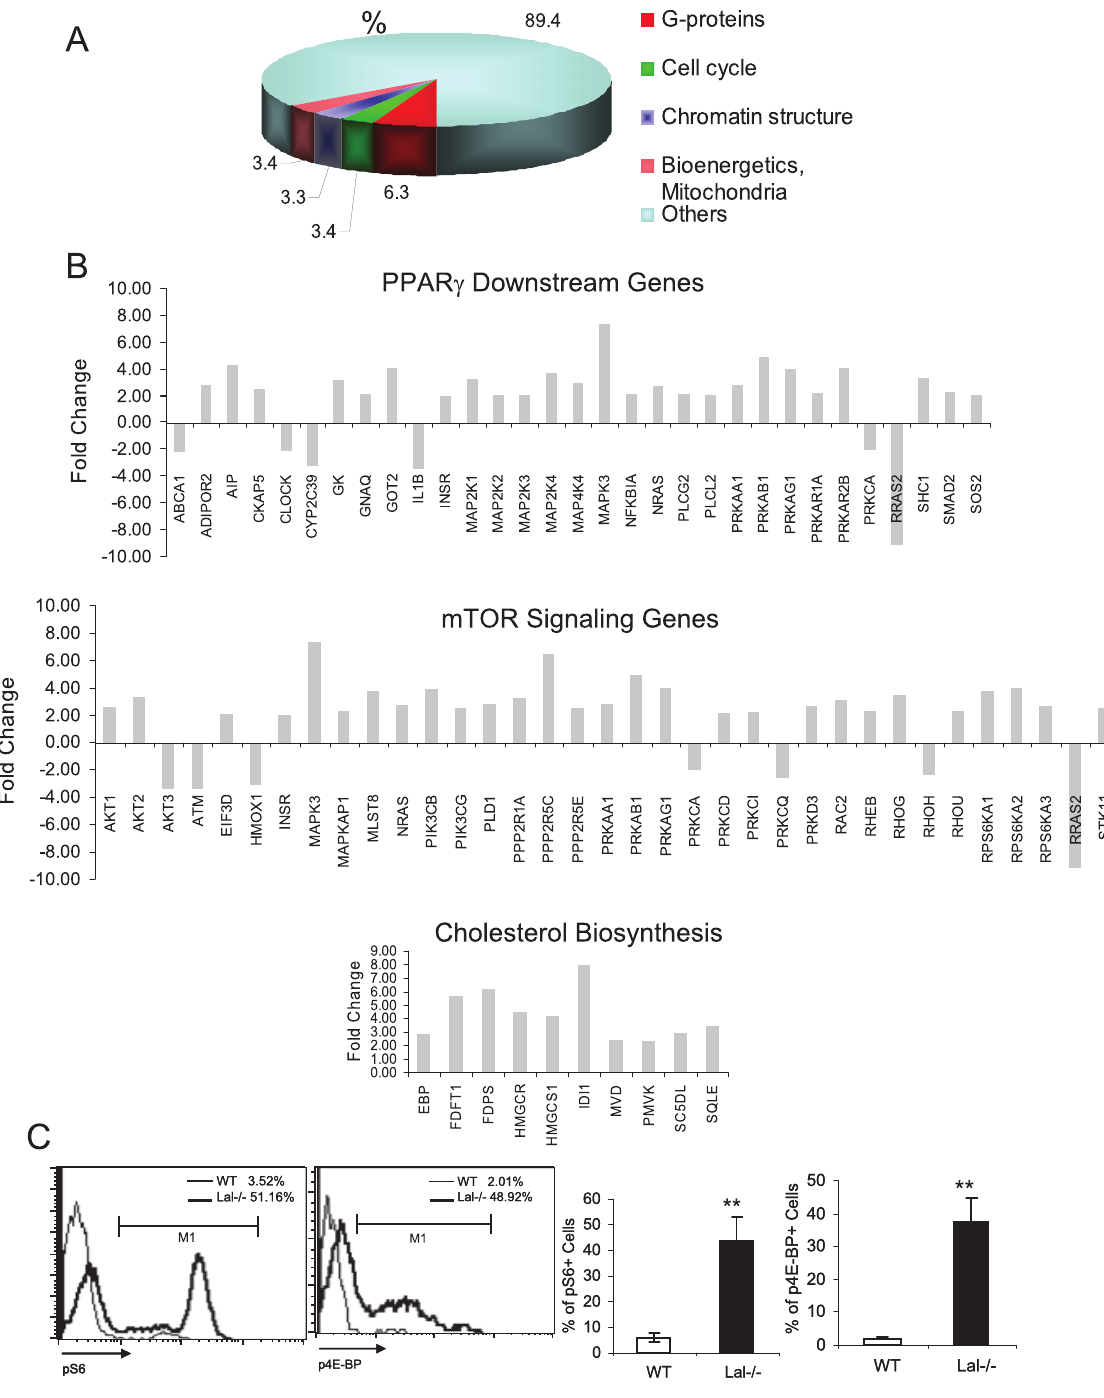
Figure 1. Affymetrix GeneChip microarray and Ingenuity Pathway analyses of lal 2 / 2 MDSCs. A ). Affymetrix GeneChip microarray analysis of Ly6G + MDSCs from the bone marrow of lal + / + mice and lal 2 / 2 mice. Numbers represent percentages of changed genes in each category vs total changed genes between lal 2 / 2 mice and lal + / + mice; B ). Differential gene expression of Ly6G + MDSCs from the bone marrow of lal + / + mice and lal 2 / 2 mice was analyzed by Ingenuity Pathway Analysis. Changed genes in the PPAR c pathway, cholesterol biosynthesis and mTOR signaling pathway are presented; C ) Flow cytometry of mTOR downstream effectors S6 and 4E-BP1 in Ly6G + MDSCs from the bone marrow of lal + / + mice and lal 2 / 2 mice. n=4.